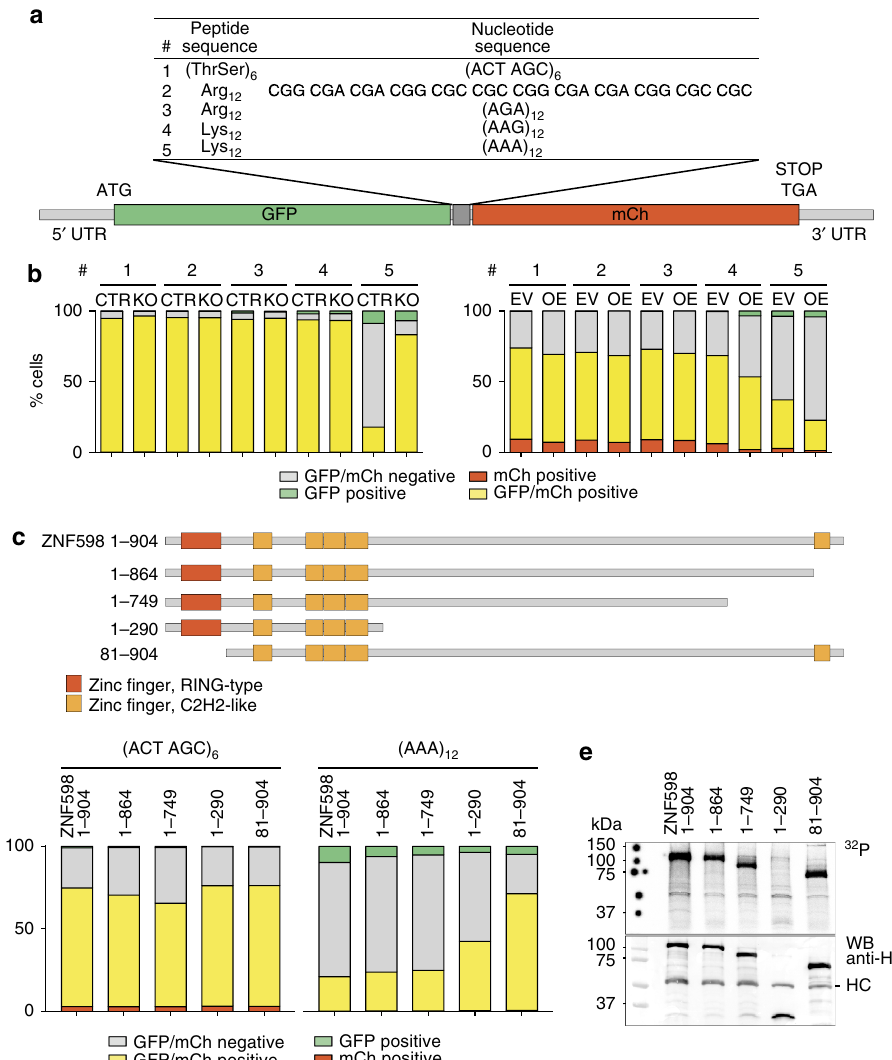
Figure 3 | The RING domain of ZNF598 is essential for ribosome stalling at polyA residing within coding sequences. ( a ) Schematic diagram of the reporter constructs sandwiching a polybasic oligopeptide track between the fluorescent GFP and mCherry (mCh) fusion protein. (ACT AGC) 6 [(ThrSer) 6 ] encoded a neutrally charged amino-acid tract that served as a control. ( b ) Detection of GFP and mCherry fluorescent signals by FACS analyses in samples from ( a ) shown as relative cell numbers. Each experiment was performed in triplicates. ( c ) Domain structures of ZNF598 full-length and truncation mutants, with numbers referring to the position of amino acids. ( d ) Detection of GFP and mCherry fluorescent signals by FACS analyses in samples expressing full-length or truncated versions of ZNF598 and transiently transfected with GFP-mCherry reporter with (ACT AGC) 6 and (AAA) 12 linkers. Each experiment was performed in triplicate. ( e ) Upper panel: autoradiograph of cross-linked, 32 P-labelled, RNA- Flag/HA-ZNF598 immunoprecipitate. Flag/HA-tagged full-length ZNF598 or truncated versions were separated by SDS-PAGE after 4SU PAR-CLIP. Lower panel: Anti-HA Western blot analyses of the cross-linked RNA-protein immunoprecipitates; HC, antibody heavy